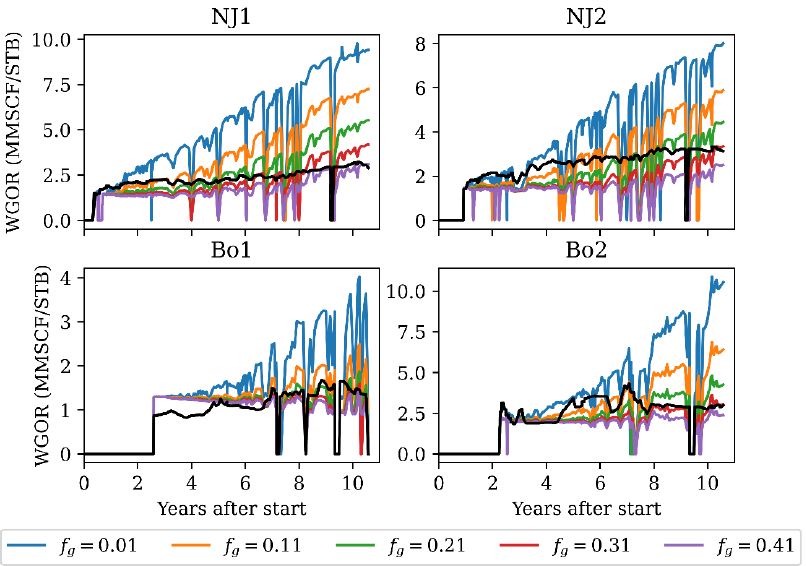
Figure 18. The produced GOR for the North Jens and Bo wells. Color coding corresponds to the relative permeabilities in Figure 4. Black lines denote the historical data.